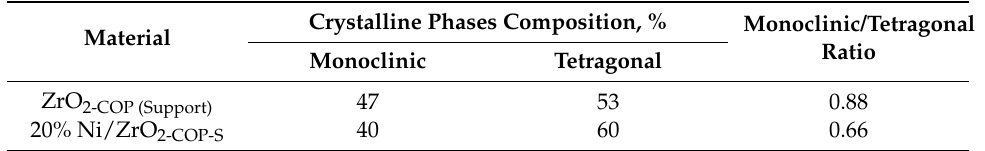
Table 3. Phase composition of the 20% Ni/ZrO 2